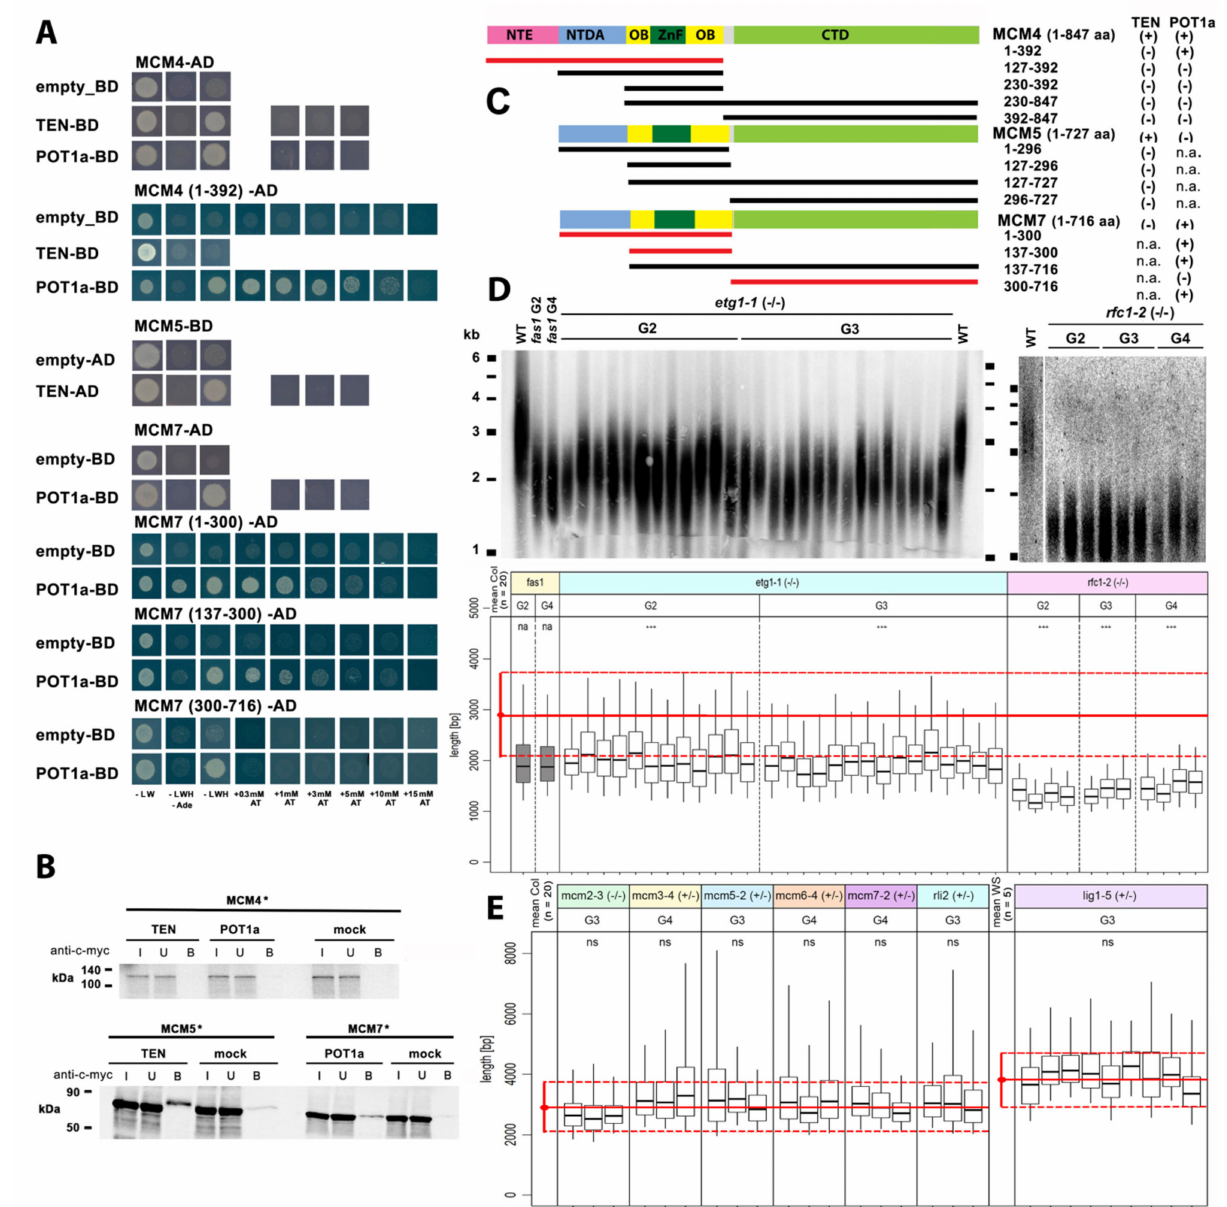
Figure 3. Analysis of protein–protein and genetic interactions of DNA replication proteins. ( A ) Results of Y2H assays using the full-length and partial constructs of MCM proteins. Positive interactions are documented on − LWHAde and − LWH selective plates supplemented with increasing concentrations of 3-aminotriazol (AT) as indicated. ( B ) Interactions between MCM proteins and TEN/POT1a were investigated using co-immunoprecipitation. Radioactively labelled (*) MCM proteins were incubated with c-myc-tagged TEN and POT1a constructs, pull-down of protein complexes using anti-c-myc coated magnetic beads confirmed positive interactions of TEN/POT1a and the full length MCM5/MCM7 proteins respectively, but not with MCM4 (I, input; U, unbound; B, bound). Protein marker in kDa. ( C ) Schema of MCM protein domain structure and design of partial constructs used in Y2H assays. The constructs cover major structural components of MCM proteins. MCM4 has an extended N terminus (NTE) with typical consensus site for CDK (cyclin-dependent kinase). All MCM proteins share a C-terminal domain (CTD) with ATPase consensus Walker motifs providing the “motor” function. The N-terminal domain (NTD) comprises NTD-A (A subdomain of NTD), a central region comprised of the zinc finger (ZnF) motifs required for oligomerization of the MCM